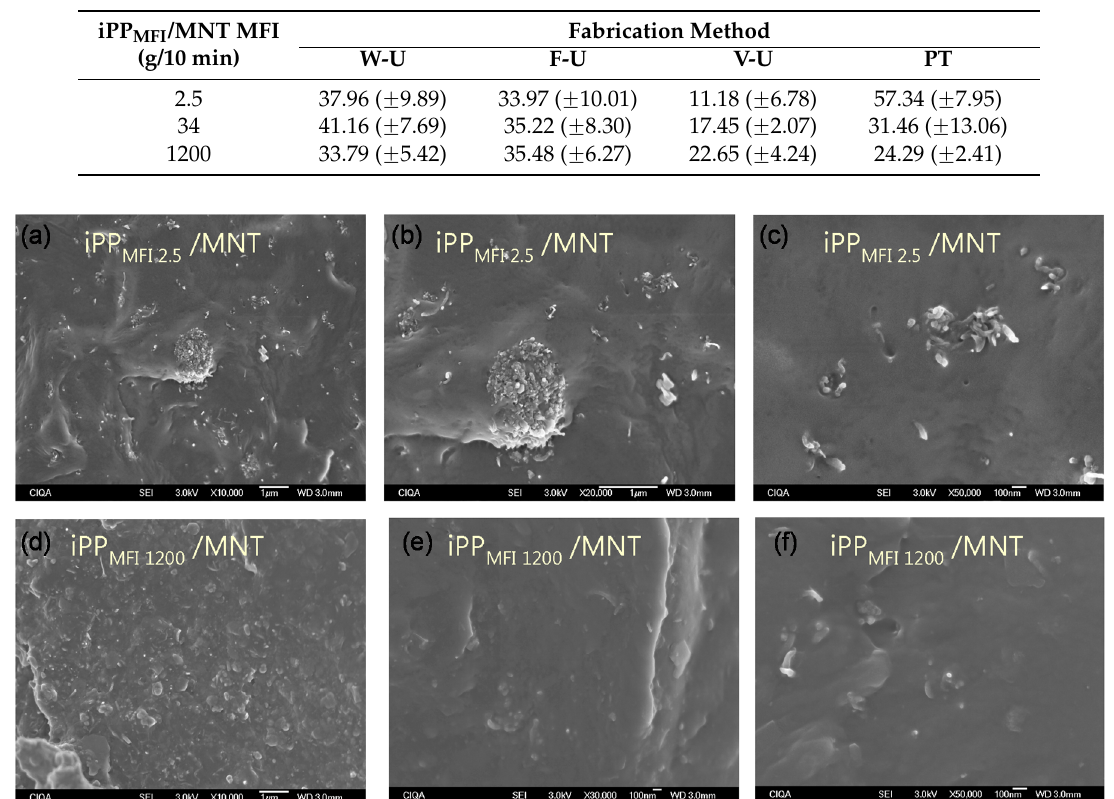
Figure 2. Scanning electron microscopy (SEM) micrographs of the surface fracture for nanocomposites of iPP/MNT (10 wt %) fabricated by melt extrusion without ultrasound ‐ assist fabrication.